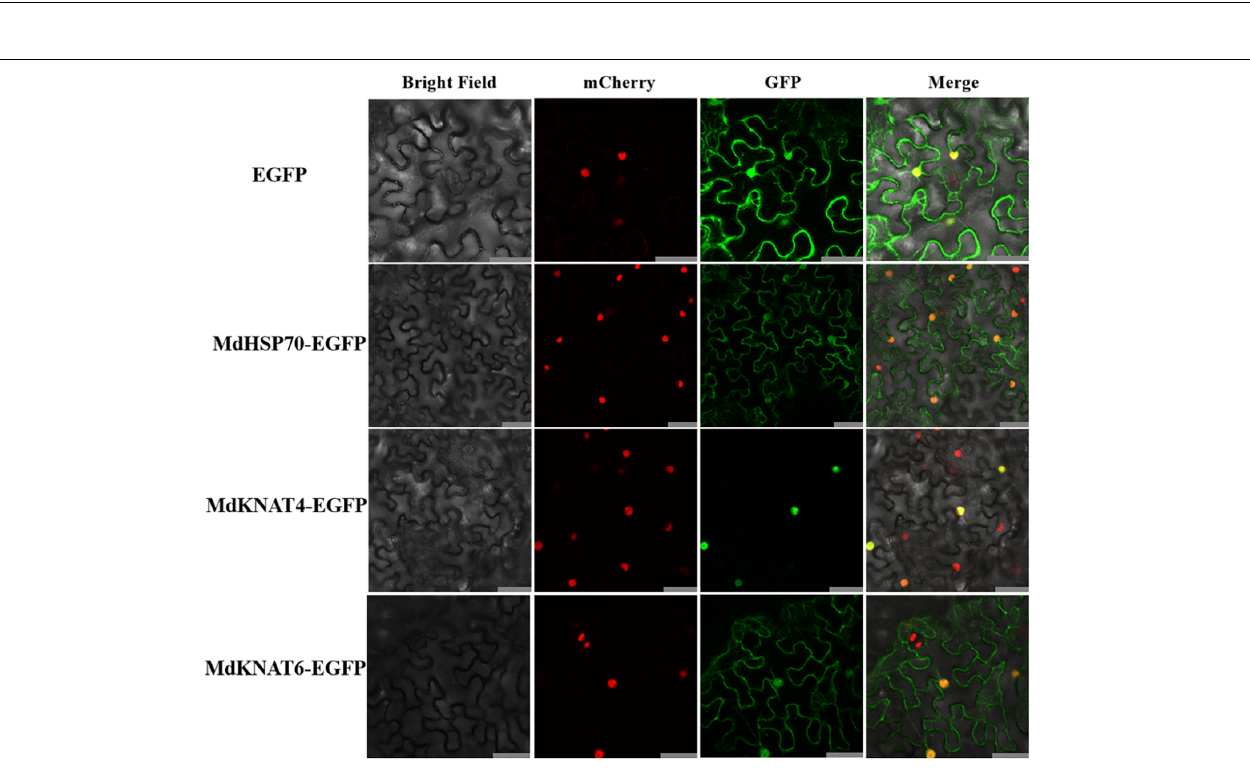
FIGURE 6 | Subcellular localisation of MdHSP70 and MdKNAT4/6. The upper panel shows 35S:EGFP, the second is 35S:MdHSP70-EGFP, the third is 35S:MdKNAT4-EGFP, and the lower panel shows 35S: MdKNAT6-EGFP. Bar = 50 µ m.